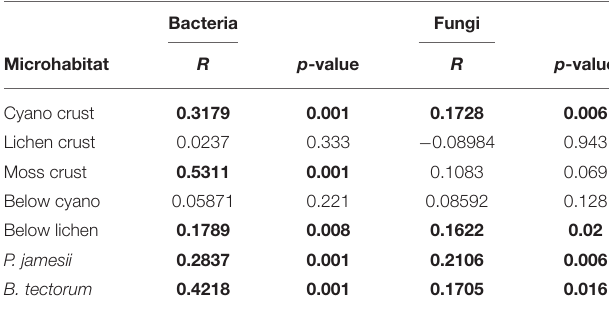
TABLE 1 | Correlations between community composition in each microhabitat and temporal distance (Mantel tests).